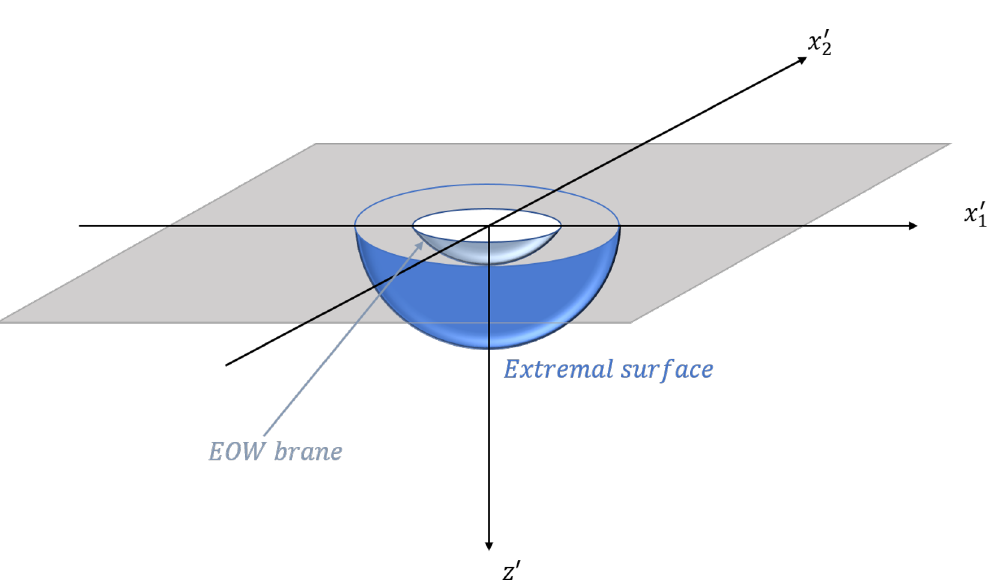
Figure 14 . The phase that extremal surface does not intersect with the EOW